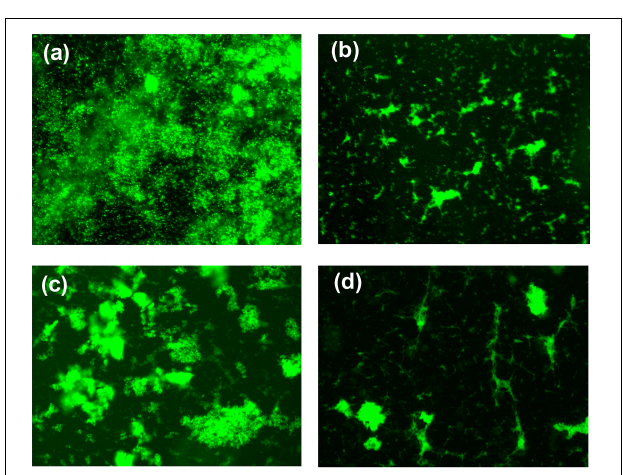
FIGURE 4 | Fluorescence microscopic image of bacterial biofilm formation untreated S. aureus (a) , hydrogel-treated S. aureus (b) , untreated P. aeruginosa (c) , and hydrogel-treated P. aeruginosa (d) . Biofilm was stained with SYTO 9 before capturing the image.